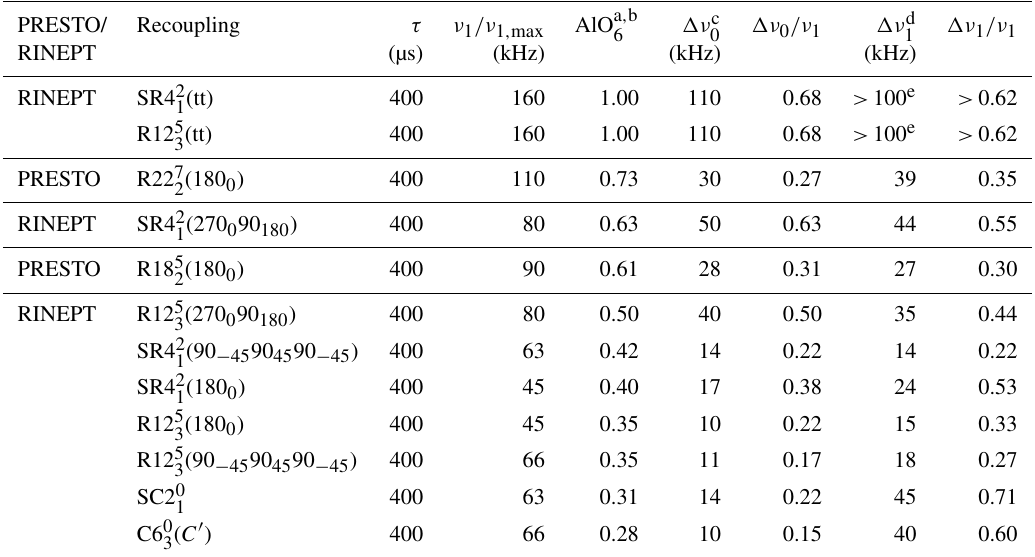
Table 1. Comparison of the performances of 1 H → 27 Al RINEPT-CWc and PRESTO transfers using various recouplings for AlO 6 signal of γ -alumina at ν R = 20kHz.